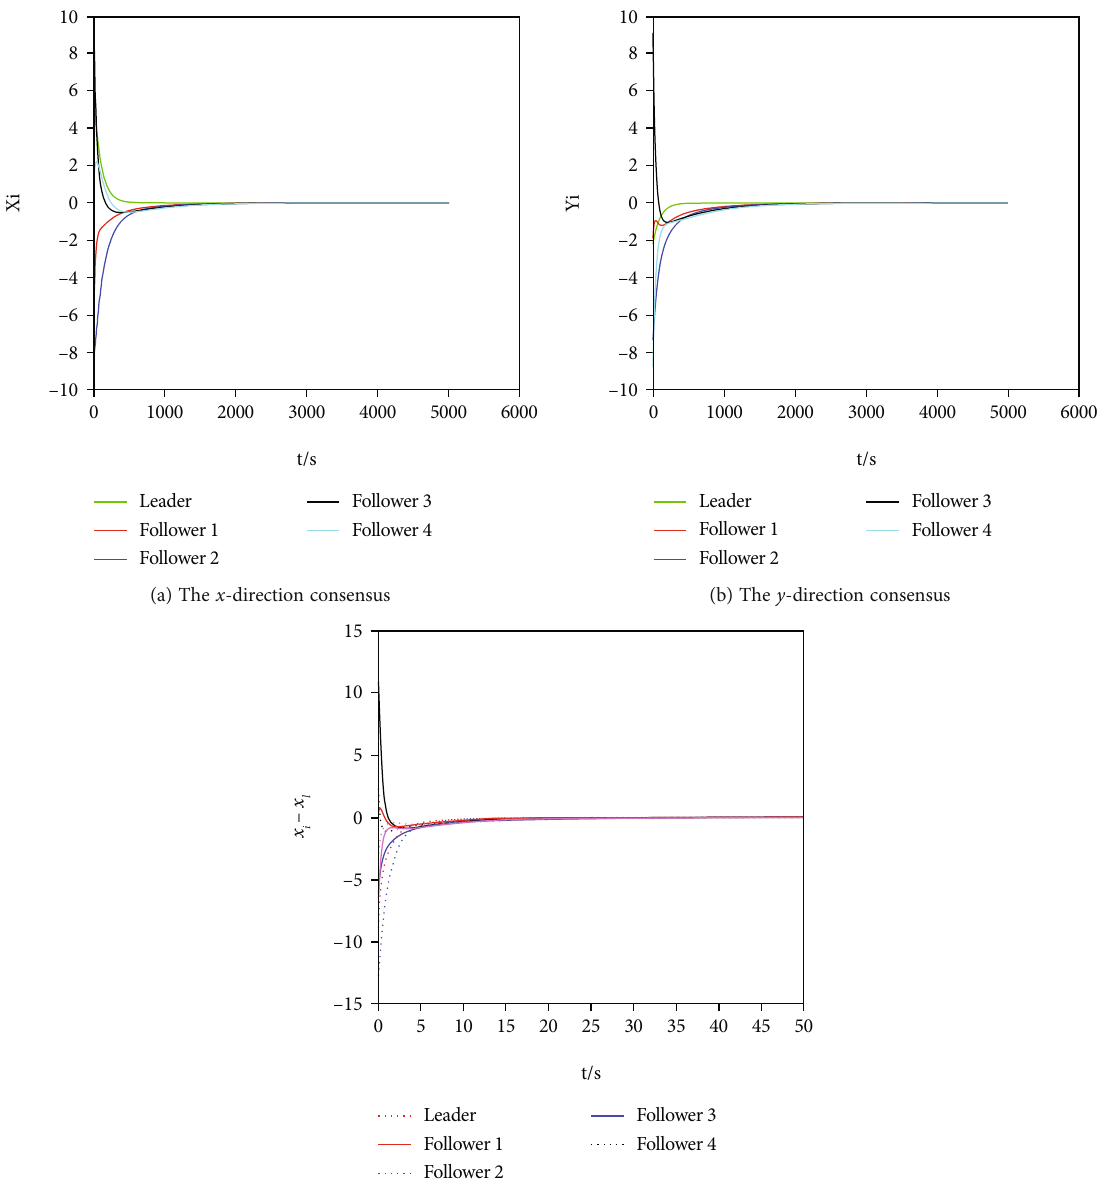
Figure 5: The consensus of formation